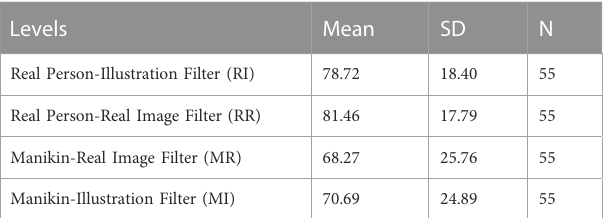
TABLE 3 Descriptive Statistics for realism